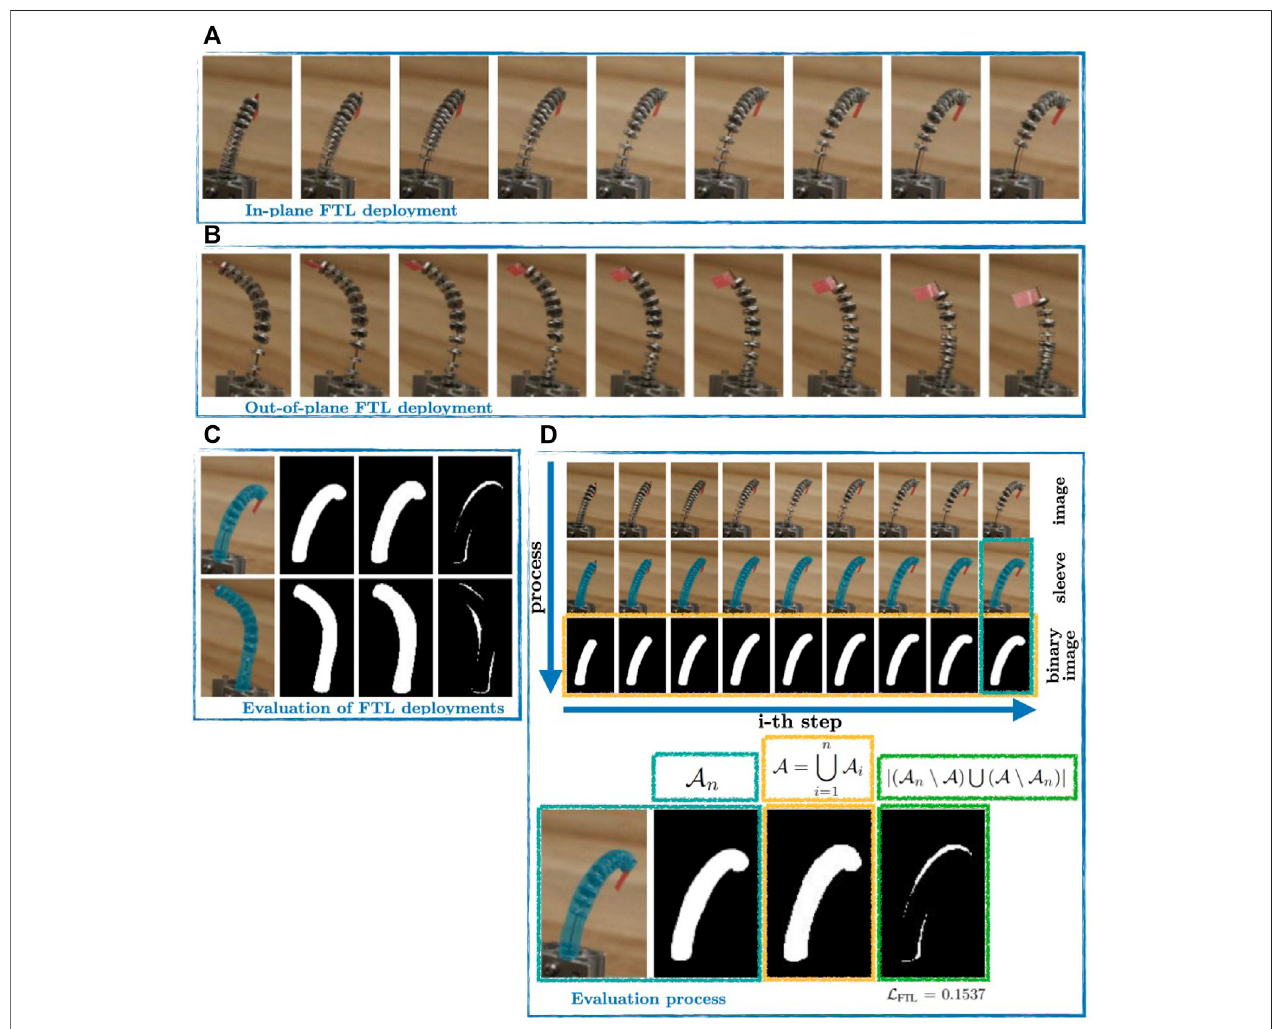
FIGURE 7 | FTL deployment with physical prototype. (A) Sequence of an in-plane FTL deployment with straight routed tendons. (B) Sequence of an out-of-plane FTL deployment non-straight routed tendons. The red fl ag on top of the end disk is used to indicate the orientation. (C) Segmented binary image of the representative sequence. The reference step is contrasted with the overlapped segmented image of all images within the sequence to obtain the binary image, which will be used for L FTL . (D) The Evaluation process as described in Section 4.2 is exemplary shown for the in-plane FTL deployment. The accompanying video provides additional visual aid.